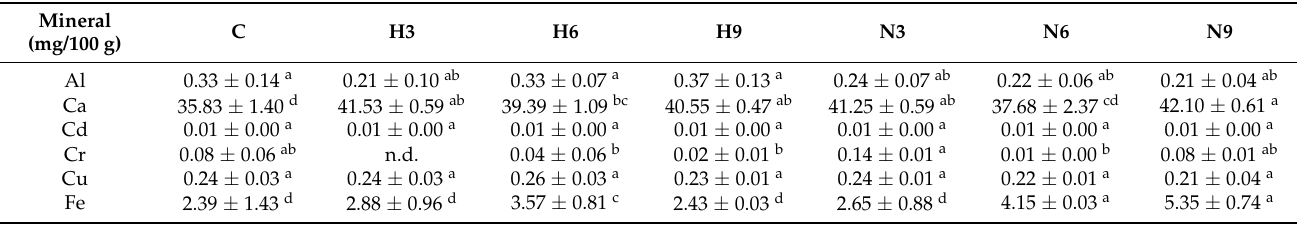
Table 4. Results of the mineral compounds profile of the prepared